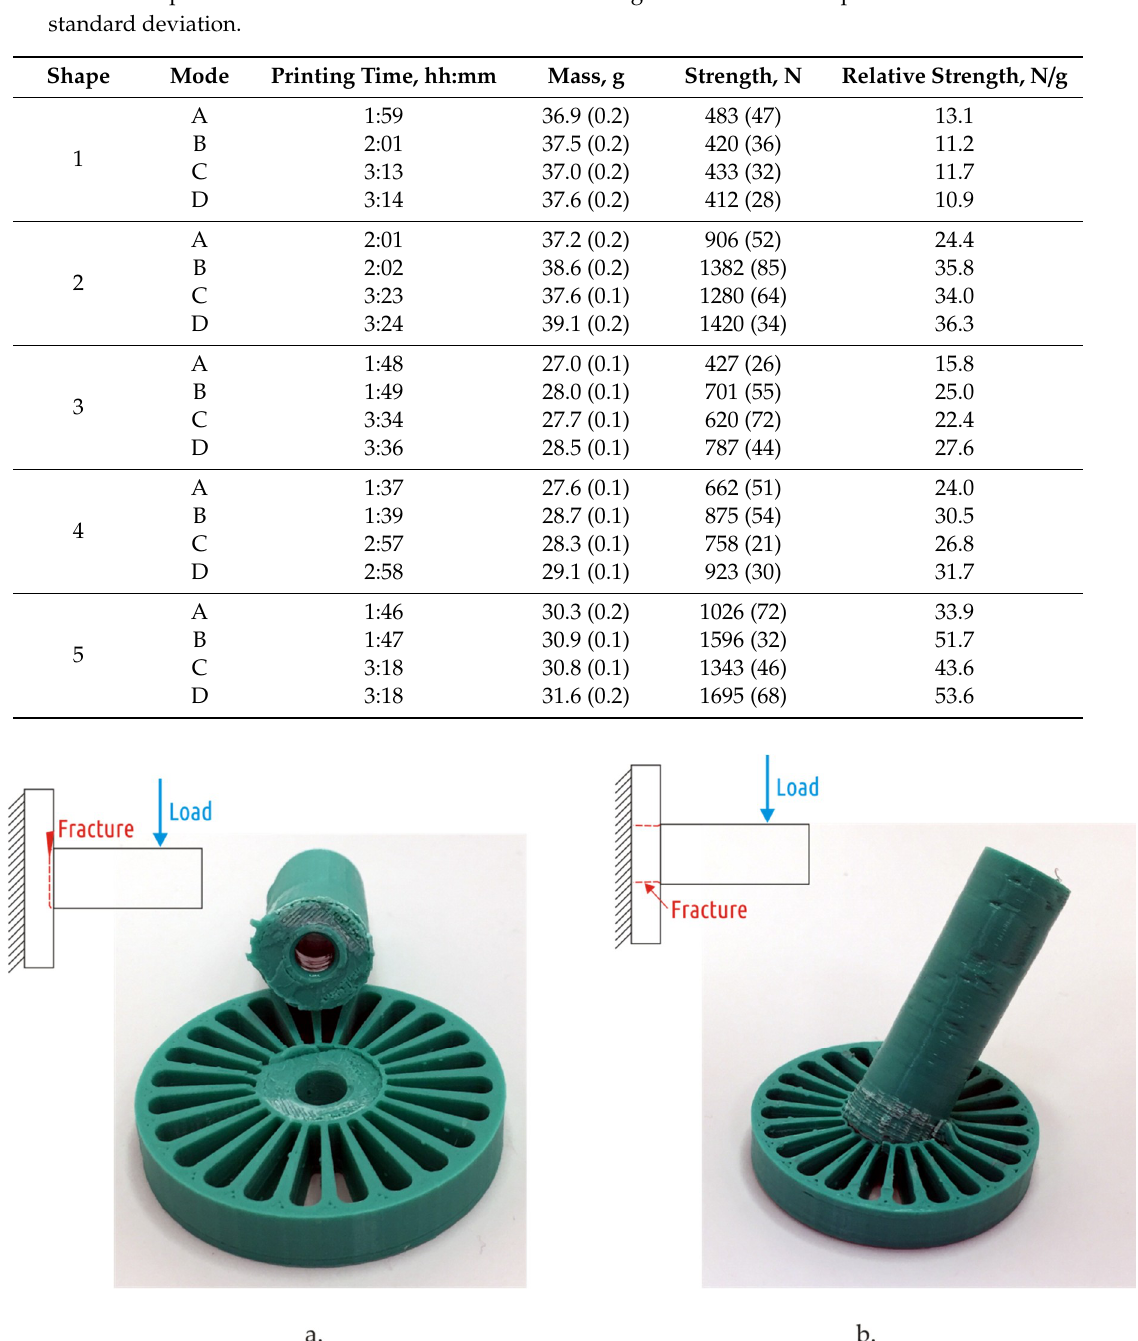
Figure 6. Destruction of Shape 3 samples printed in mode A [64] ( a ) and mode B ( b ). For the mode B sample, after the test is over, it is still not possible to separate the shaft from the boss with bare hands.